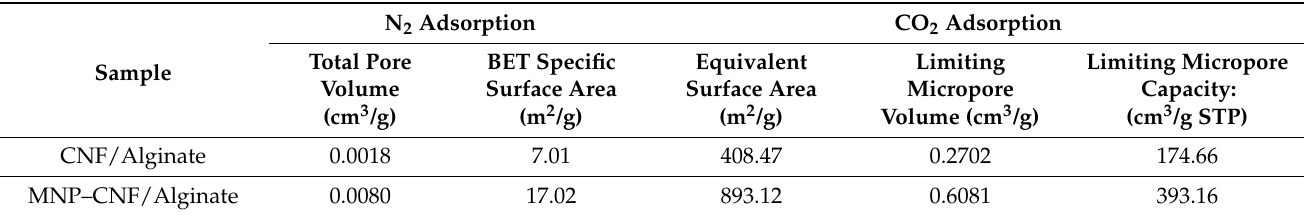
Figure 5. ( A ) N 2 adsorption isotherm at − 196 °C. ( B ) CO 2 adsorption isotherm at 0 °C. ( C ) Incremental (main axis in blue) and cumulative pore volume (secondary axis in red) as a function of pore width calculated from N 2 adsorption isotherm. ( D ) Incremental (main axis in blue) and cumulative micropore (secondary axis in red) volume as a function of pore width calculated from CO 2 adsorption isotherm of CNF/alginate and MNP–CNF/alginate. Table 2. Microporous properties of composite gel beads.